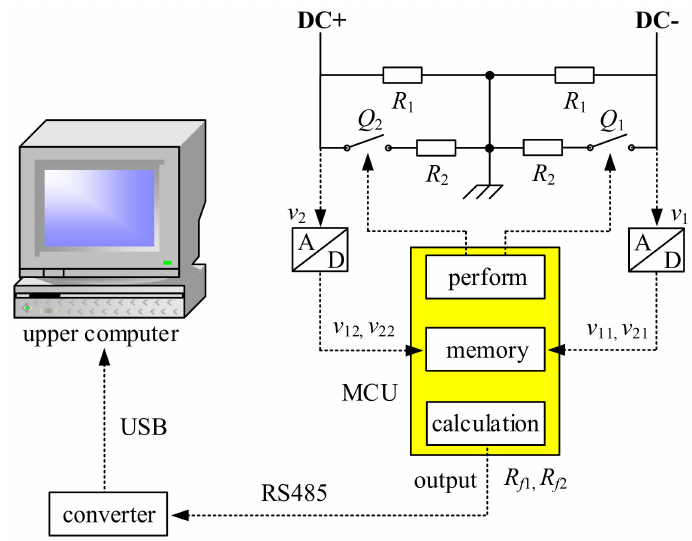
Figure 8. The schematic overview of